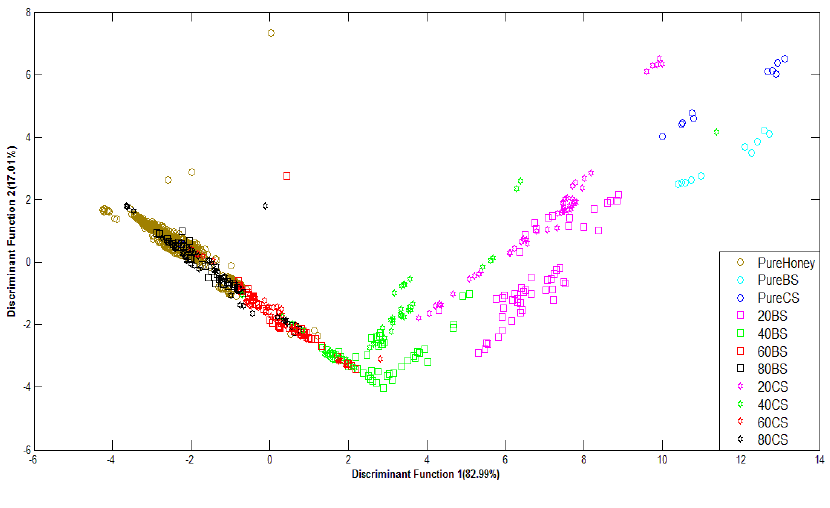
Figure 9. LDA plot of normalized FTIR data.